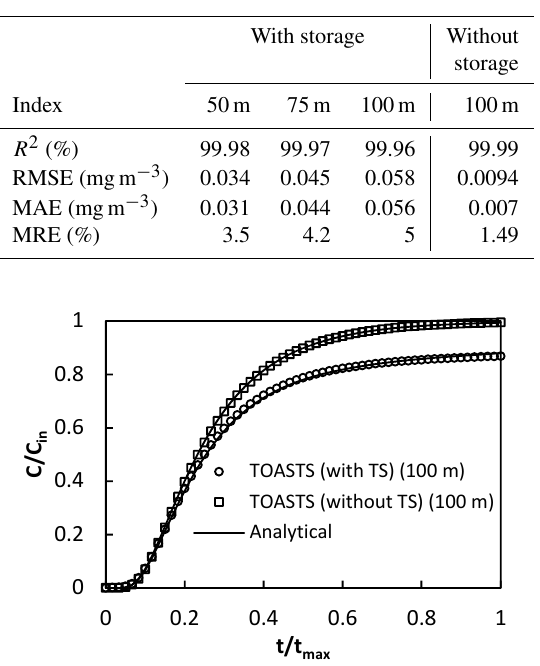
Table 4. Error indices of verification by the analytical solution for Heaviside boundary condition.